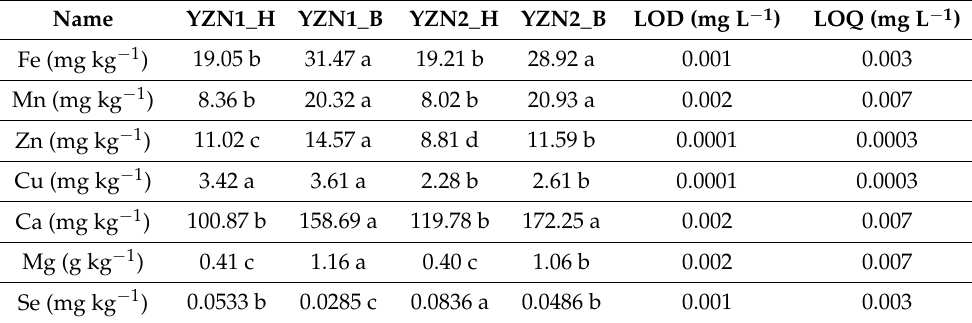
Table 3. Difference analysis of the nutrient levels in brown rice of two purple rice varieties after processing to polished